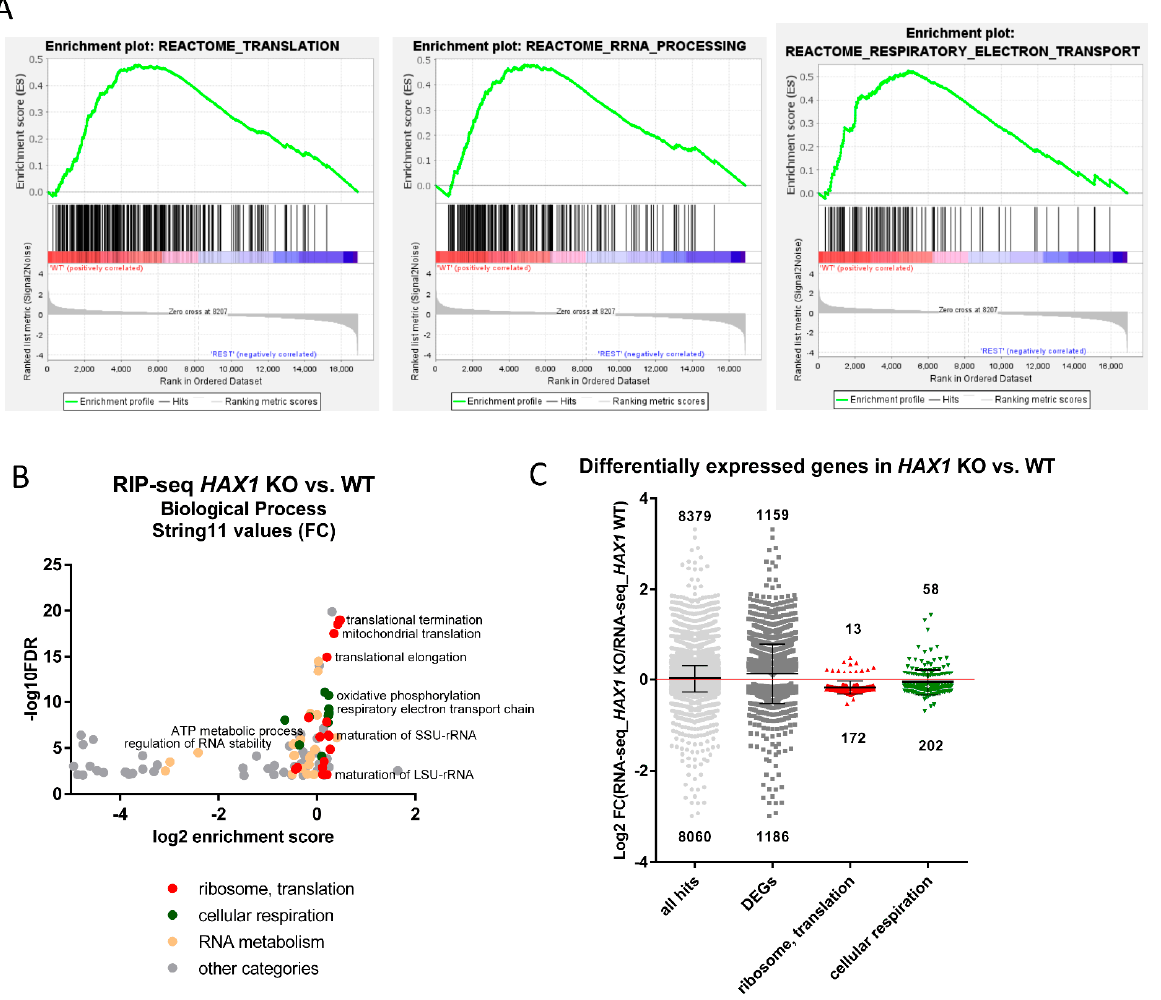
Figure 5. HAX1 KO affects the expression profile in HL-60 cells. ( A ) Enrichment plots generated by GSEA analysis for the chosen categories (translation, rRNA processing, respiratory electron transport) ( B ) Enrichment in GO Biological Process terms for genes differentially expressed in HAX1 KO vs. HAX1 WT (String 11 weighted analysis with log2[RNA-Seq_HAX1_KO/RNA-Seq WT]